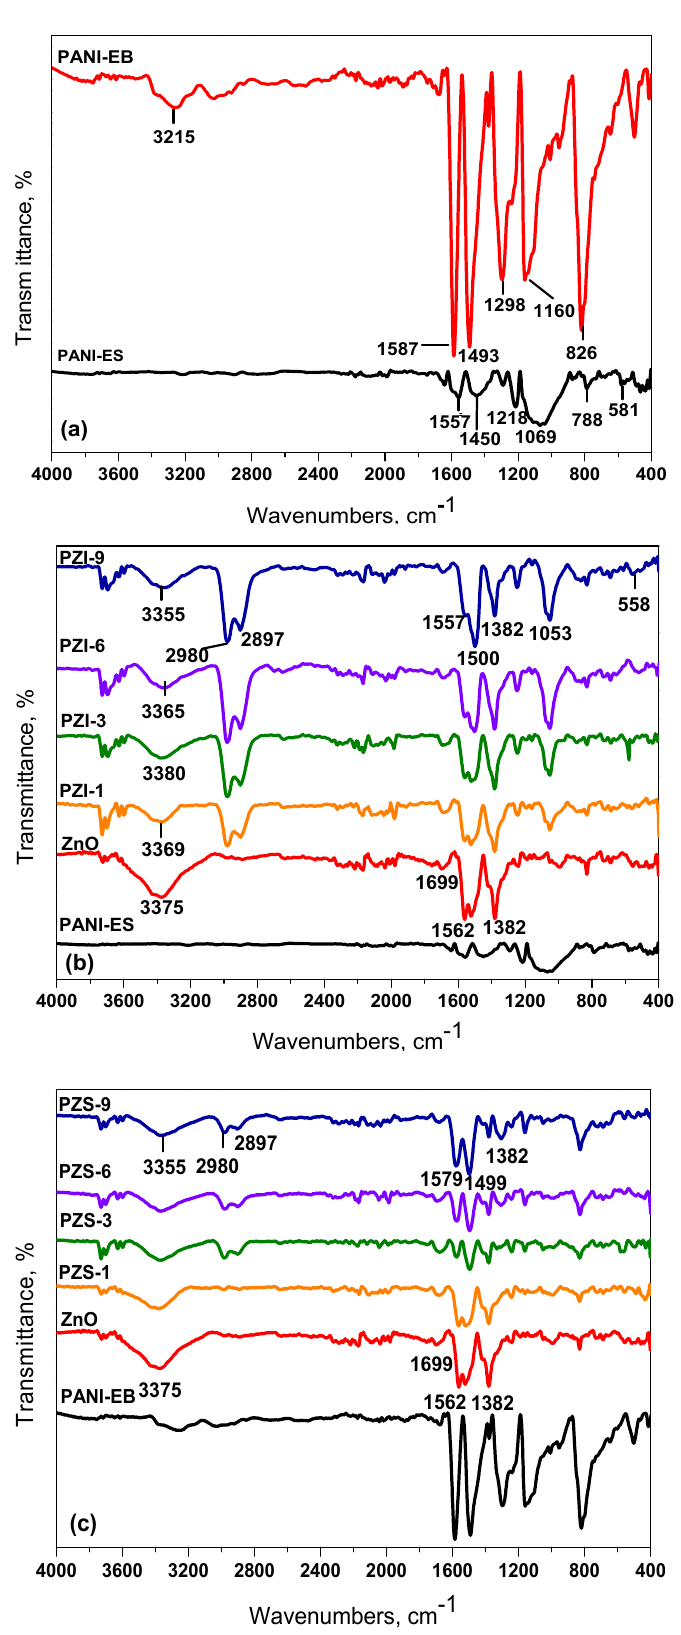
Figure 2. Stacked Fourier Transform Infrared (FT-IR) spectra of ( a ) PANI-ES and PANI-EB, ( b ) PANI-ES, zinc oxide (ZnO) and PANI-ZnO composites using In-situ chemical oxidation polymerization method (PZI), ( c ) PANI-EB, ZnO and PANI-ZnO composites by hybridization method (PZS).